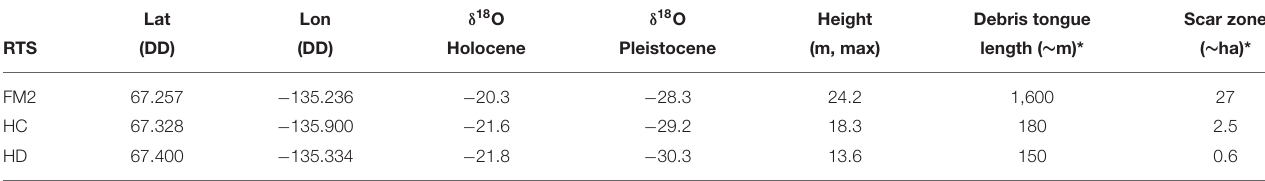
TABLE 1 | Characteristics of RTS features in this study.